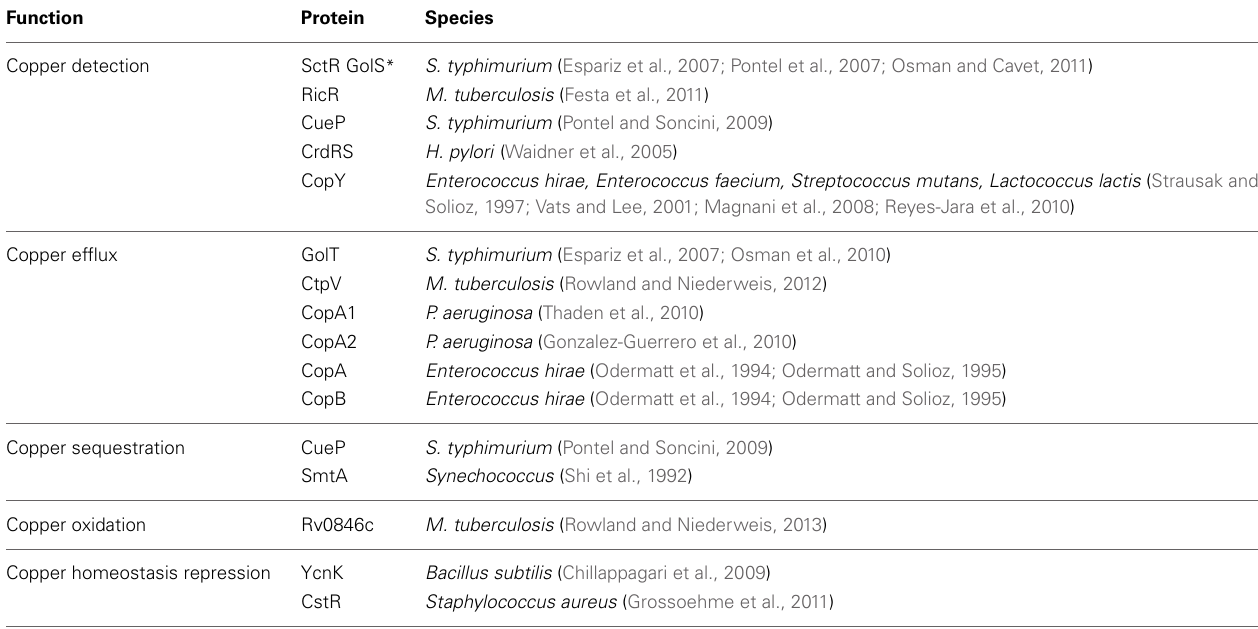
Table 1 | Species-wide distribution of copper-resistance